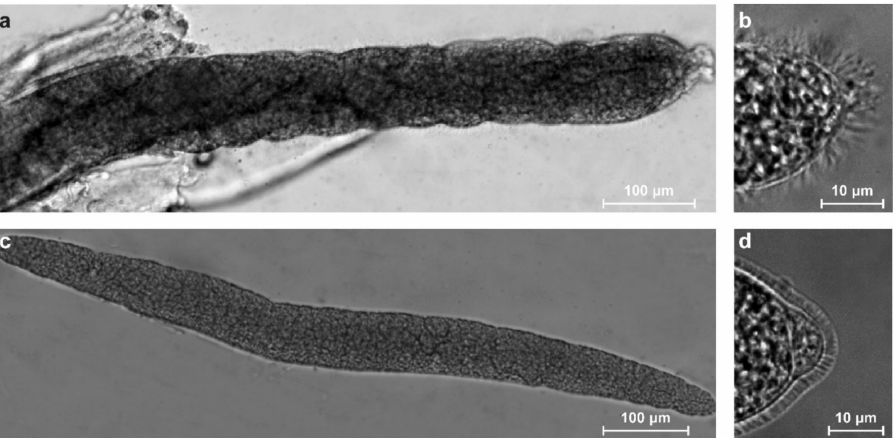
Figure 1. Morphologies of S . arieticanis and S . tenella isolated from the diaphragm of sheep as observed under a light microscope. Fresh preparations: ( a , b ) S . arieticanis ; ( c , d ) S . tenella . ( a ) Fragment of ribbon-shaped sarcocyst incorporated in muscle tissues. ( b ) A portion of sarcocyst wall with irregularly arranged hair-like protrusions. ( c ) A spindle-shaped sarcocyst released from muscle tissues. ( d ) A portion of sarcocyst wall with densely packed finger-like